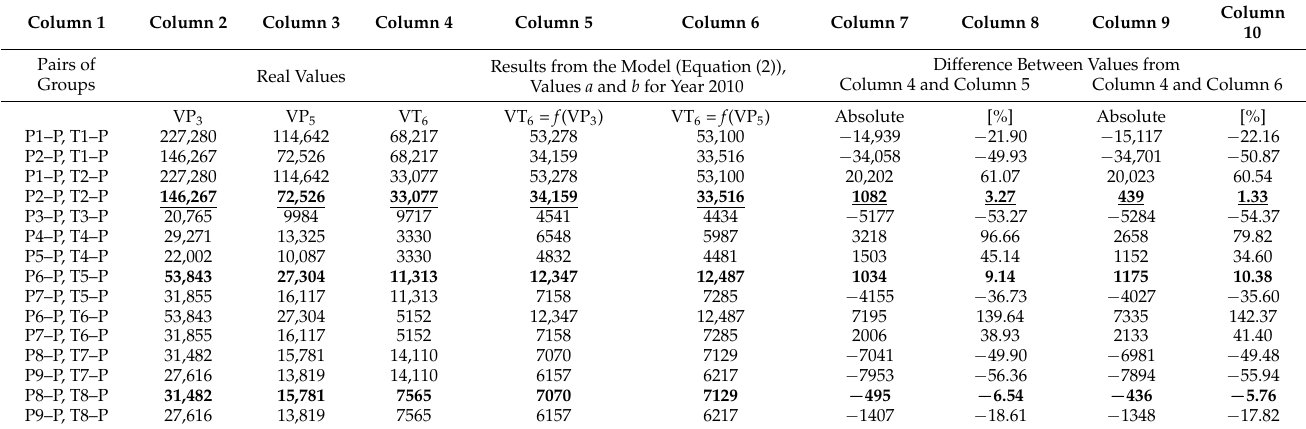
Table 16. Differences between modeled and real traffic values for specified pairs of groups. Bold numbers signify three best pairs of groups providing the best results, the best pair being additionally